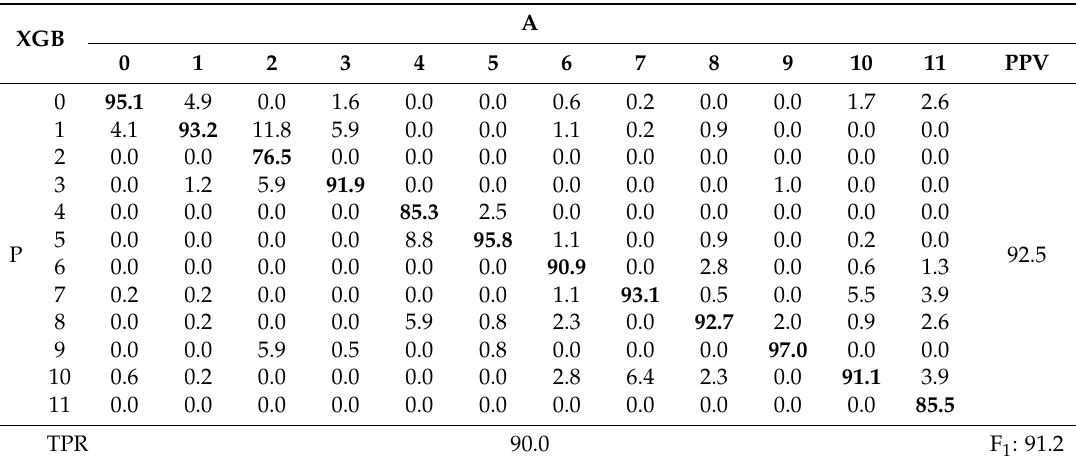
Table 16. The Confusion Matrix of the XGBoost